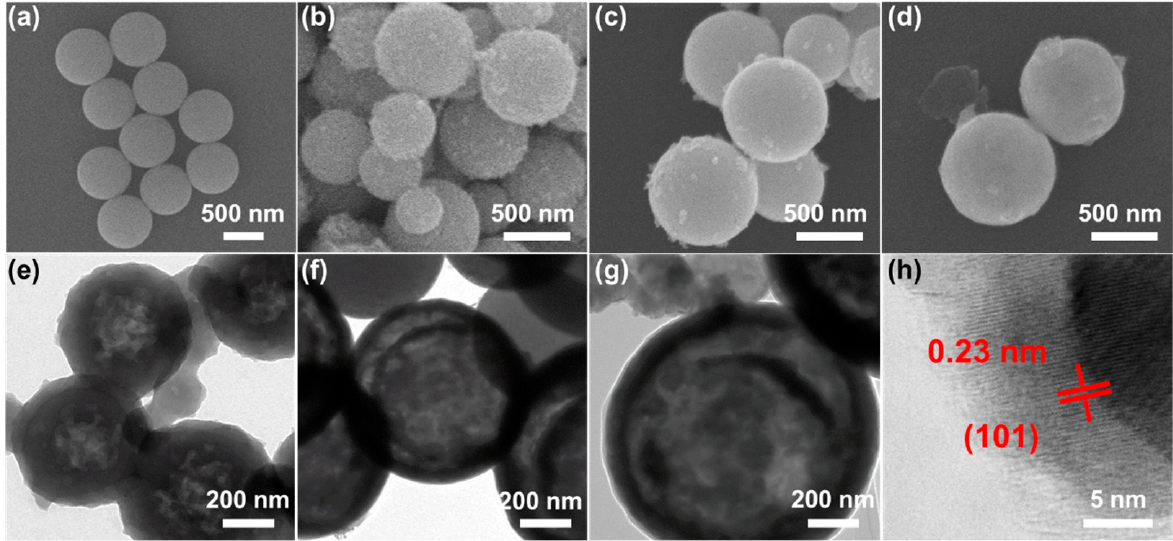
Figure 2. SEM image of Mo-PD ( a ); SEM images of DS-Mo 2 C/C microsphere at different pyrolysis temperatures: 700 °C ( b ), 800 °C ( c ), and 900 °C ( d ); TEM images of DS − Mo 2 C/C microsphere at